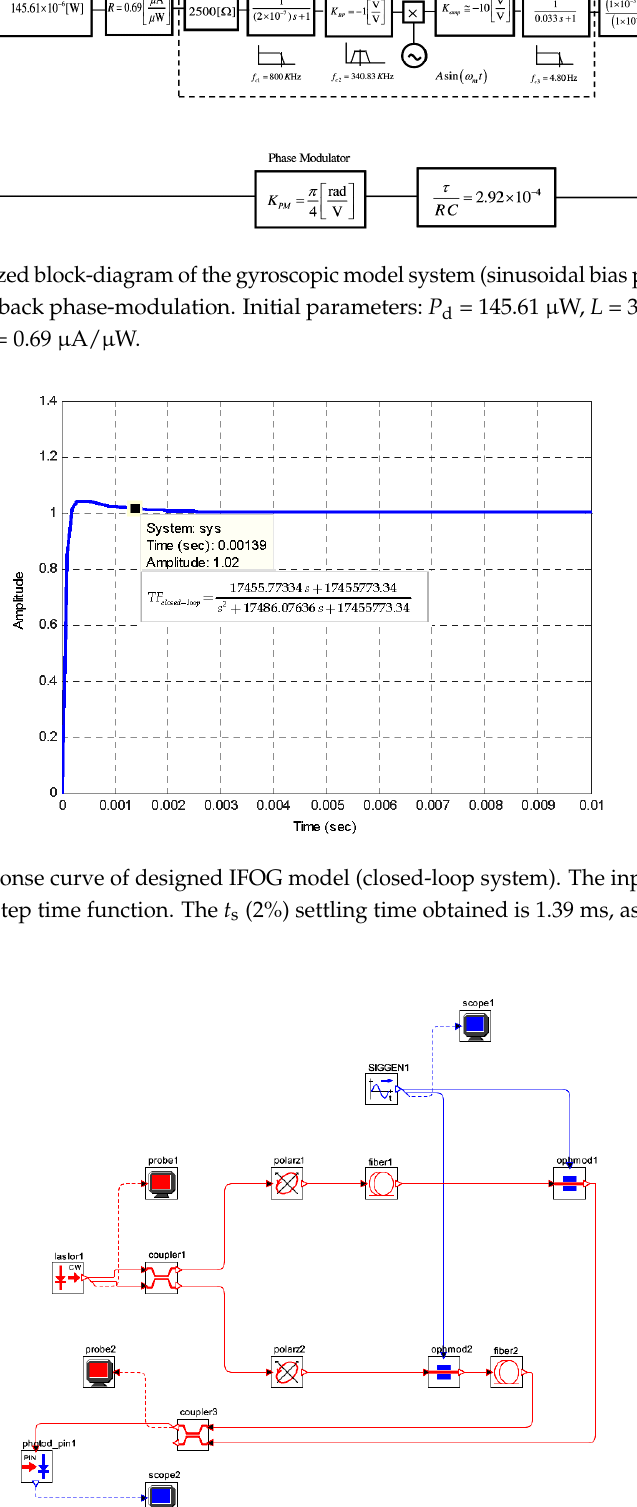
Figure 9. Optical circuit setup of the designed IFOG gyroscope for computer simulation (OptSim™).